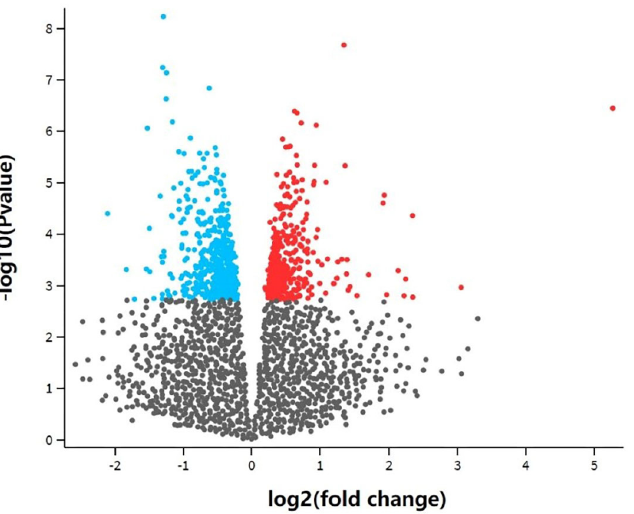
Figure 4. Differential gene volcano plot of transcriptome analysis. The blue part represents down- regulated genes, the red part represents up-regulated genes and the grey part represents non- differential genes. The differentially expressed genes were obtained using GEO2R. There was a total of 891 differentially expressed